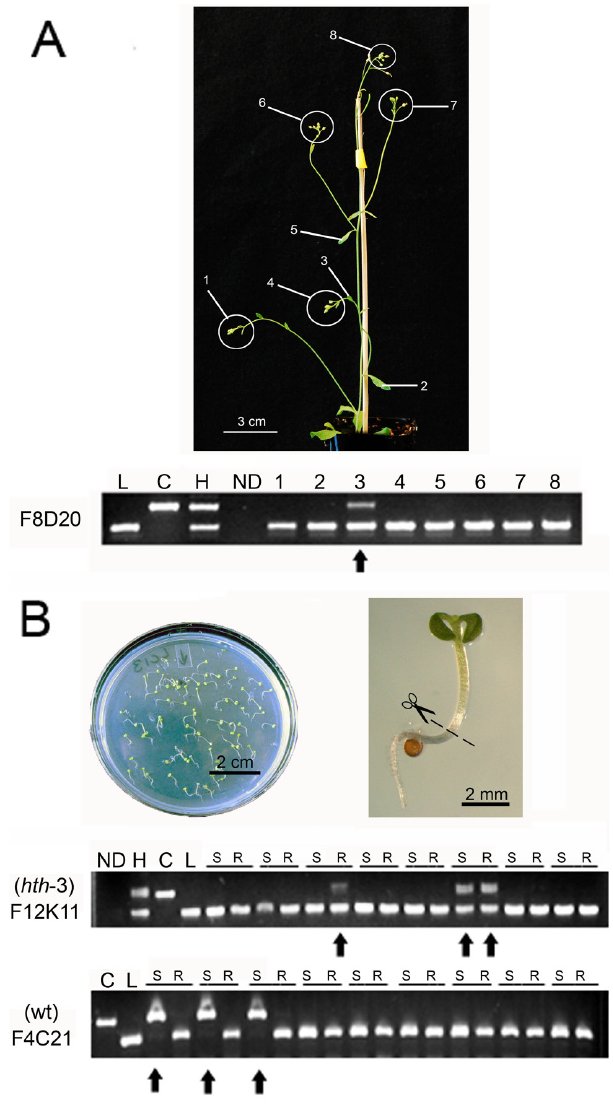
Figure 3. Molecular analysis of an adult mutant plant and bisected mutant and wt seedlings. ( A ) DNA was extracted from multiple tissue samples and PCR-amplified using F8D20 primers. A novel PCR amplicon product corresponding in size to the insertion allele (C) was detected in hth-7 tissue sample 3 (arrow). ( B ) Sterile seeds were sown onto petri plates (top left) and 5-day old seedlings cut at the root-shoot junction (illustrated in the top right panel) and genotyped individually. DNA extracted from shoot (S) and root (R) samples derived from individual hth-3 or wt seedlings were PCR-amplified using F12K11 and F4C21 primers, respectively. Samples were loaded in pairs (indicated by horizontal bars). Novel amplicon bands were detected in five seedling samples (arrows) that correspond in size to the insertion allele (C). In one hth-3 sample, both organs (S, R) had a novel band, while a novel amplicon was detected only in the root in a second sample. In three cases, DNA extracted from wt seedlings gave rise to novel bands corresponding in size to the insertion allele (C) (arrows, S). In both cases, the parent plant was homozygous for the deletion allele (L) at the corresponding marker. Heterozygote (H), no DNA control sample